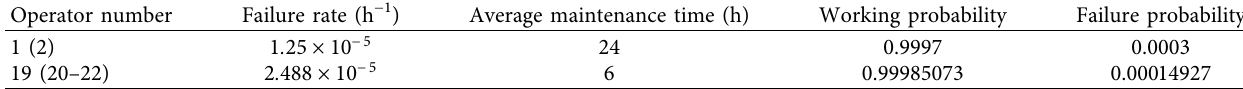
Table 5: Reliability parameters of operators 1 (2) and 19 (20–22).